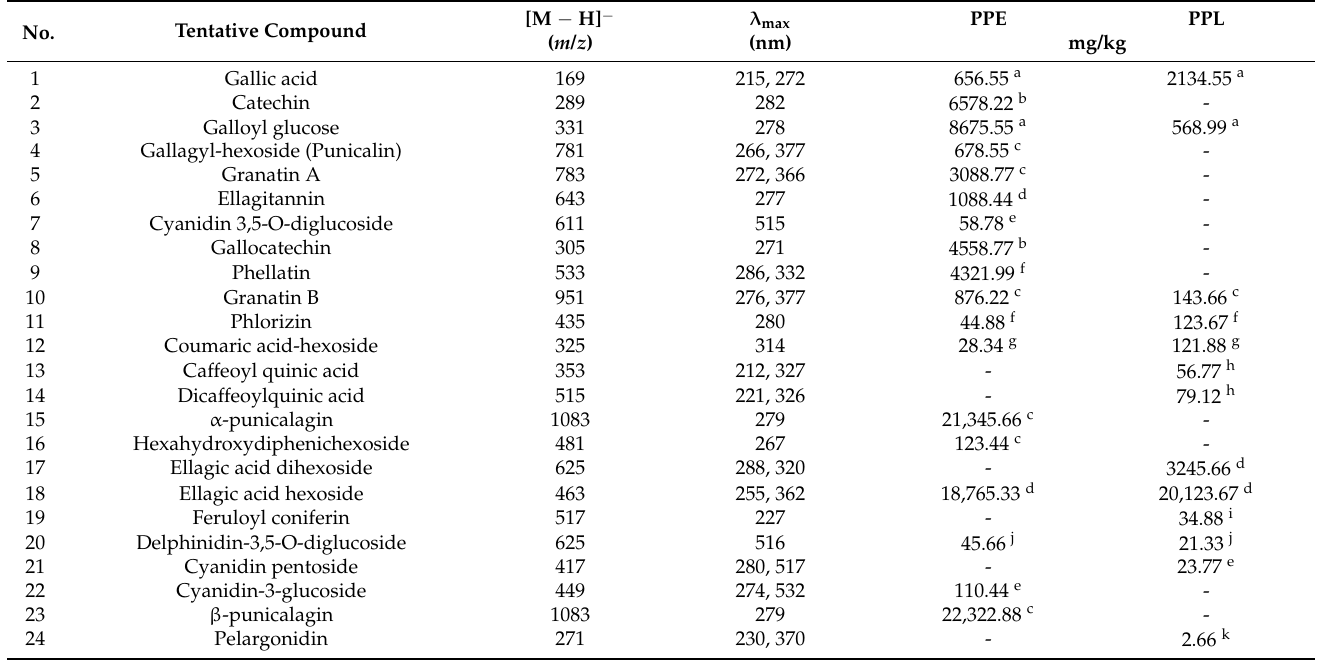
Table 1. Tentative identification and quantification of polyphenols in pomegranate peel and leaf extracts (PPE and PLE, respectively) by LC-PDA-ESI-MS analysis.